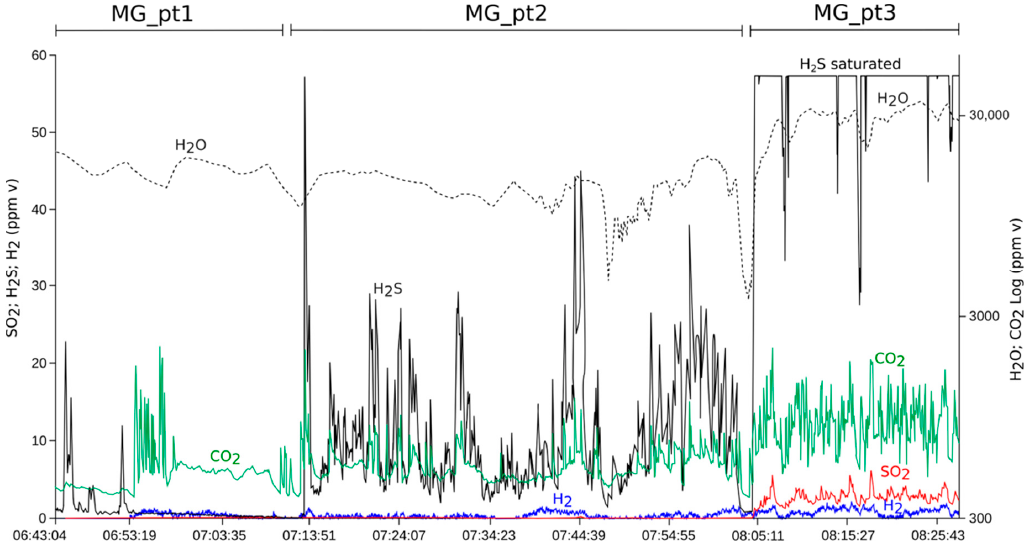
Figure 3. Gas composition recorded at 3 degassing points (MG_pt1, MG_pt2, MG_pt3) with H 2 O in a dotted line whilst H 2 S, CO 2 , SO 2 , and H 2 in black, green, red and blue, respectively. H 2 S result is saturated at the point